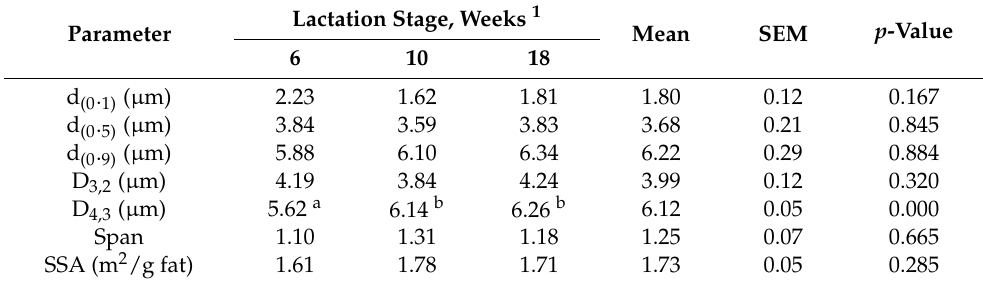
Table 5. Calculated parameters from the size distribution of fat globules in red deer milk during lactation. Lactation Stage, Weeks 1 Parameter